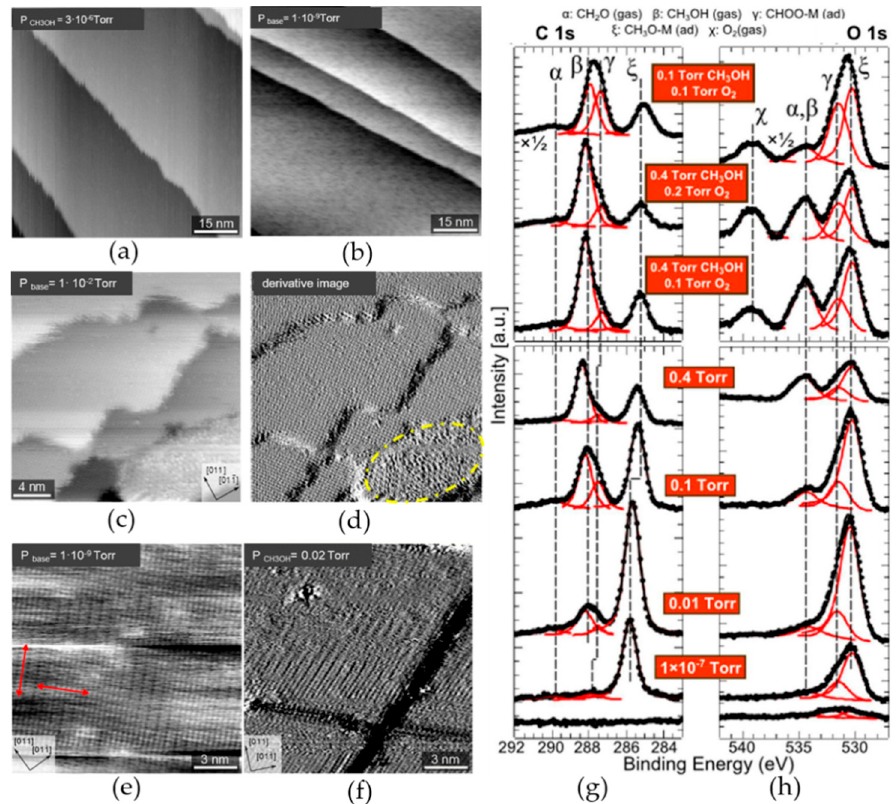
Figure 7. STM images of the Cu(100) surface at 298 K after preparation ( a ) at pressure of 1 × 10 − 9 Torr (mostly water in the background), ( b ) in the presence of 3 × 10 − 6 Torr of gas phase methanol. STM images of the Cu(100) surface at 298 K ( c ) in the presence of 0.01 Torr of gas phase methanol, ( d ) the derivative image of ( c ) to enhance the STM contrast on the terraces. The region enclosed by the yellow broken line has not yet been determined. STM images of the Cu(100)-(2 √2 × √2 R45°)-O surface at 298 K ( e ) at UHV, ( f ) in the presence of 0.02 Torr of CH 3 OH. ( g ) C 1s and ( h ) O 1s regions of the AP-XPS spectra of Cu (100) at 298 K in the presence of gas phase methanol (lower panels) and methanol mixed with O2 (upper panels). From bottom to top: in UHV, under 1 × 10 − 7 Torr of CH 3 OH, under 0.01 Torr of CH 3 OH, under 0.1 Torr of CH 3 OH, under 0.4 Torr of CH 3 OH, under 0.4 Torr of CH 3 OH + 0.1 Torr of O 2 , and under 0.4 Torr of CH 3 OH + 0.2 Torr of O 2 .